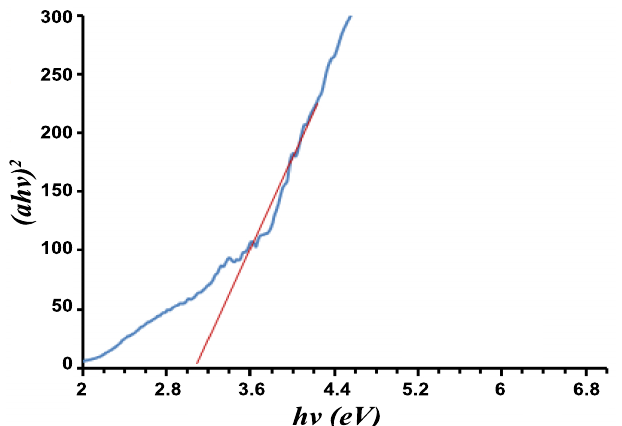
Fig. 5. Optical absorption graph of